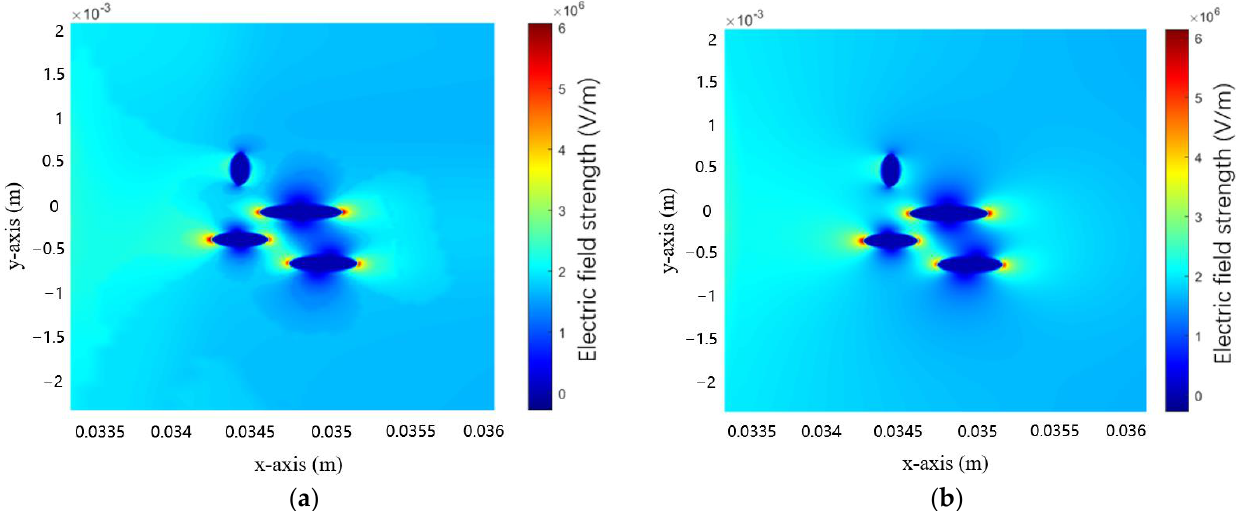
Figure 7. Local enlargement of the calculated values of the data-driven model for changing voltage parameters compared with the calculated values of the finite element method, ( a ) Electric field strength at impurities calculated by data-driven model, ( b ) Electric field strength at impurities calculated by finite element.